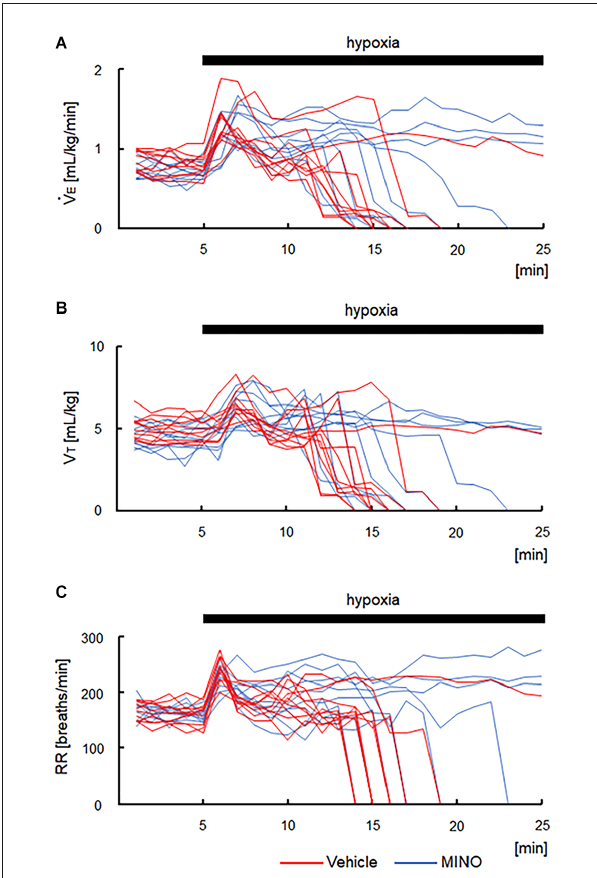
FIGURE3 Timecoursesofrespiratoryvariablesinthevehicle-andminocycline pre-treated conditions before and during 5% hypoxia. (A) Minute ventilation ( ˙ V E ). (B) Tidal volume (V T ) in each mouse. (C) Respiratory rate (RR). As compared to vehicle-pre-treated mice, minocycline- pre-treated mice tended to resist respiratory depression and respiratory arrest during the late hypoxic phase. MINO,